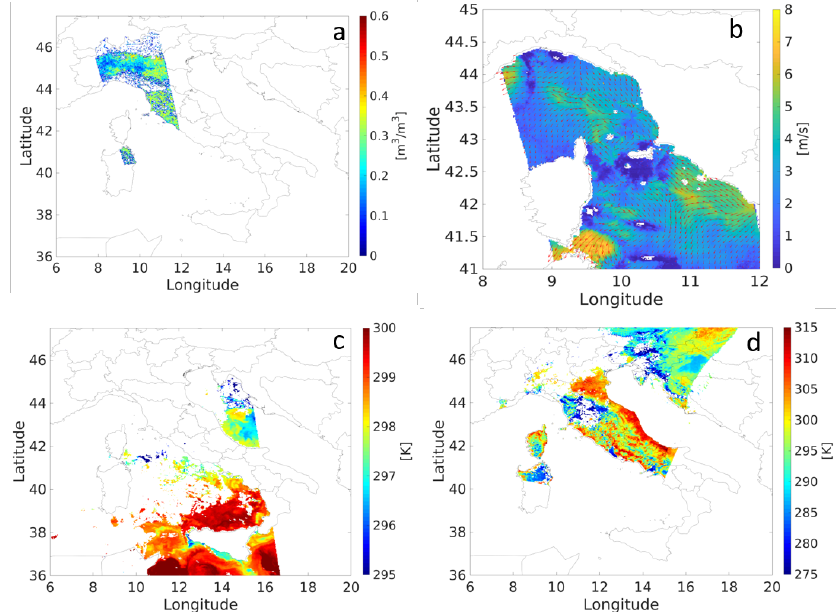
Figure 5. Sentinel observational data available for the Livorno test case. Soil moisture in panel ( a ), wind speed and direction in panel ( b ), Sea Surface Temperature in panel ( c ) and Land Surface Temperature in panel ( d